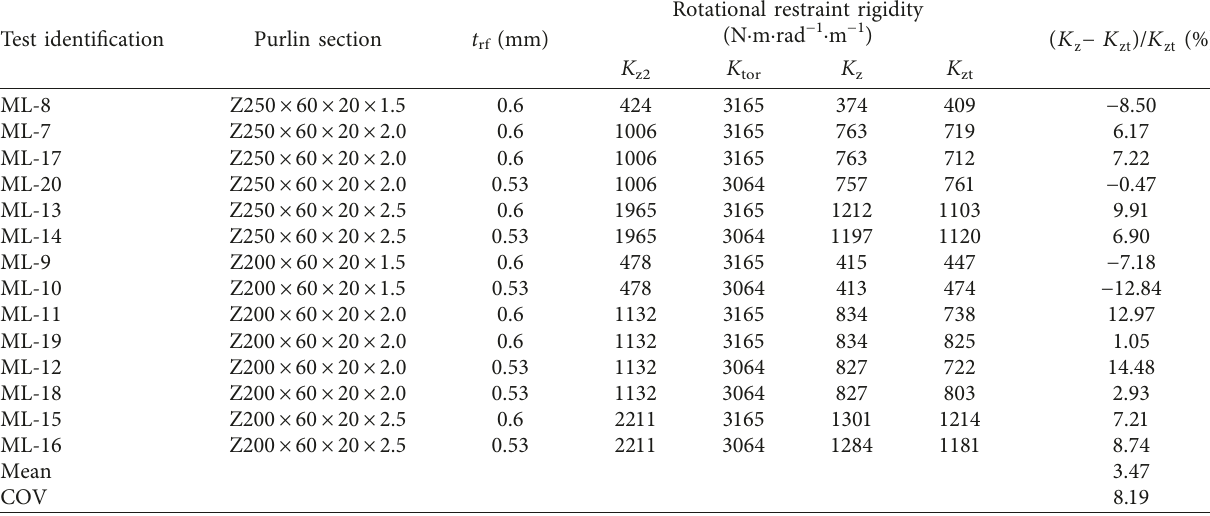
Table 1: Comparison of rotational restraint rigidity calculated by Equation (3) with test result by Liu et al. [20]. Test identification